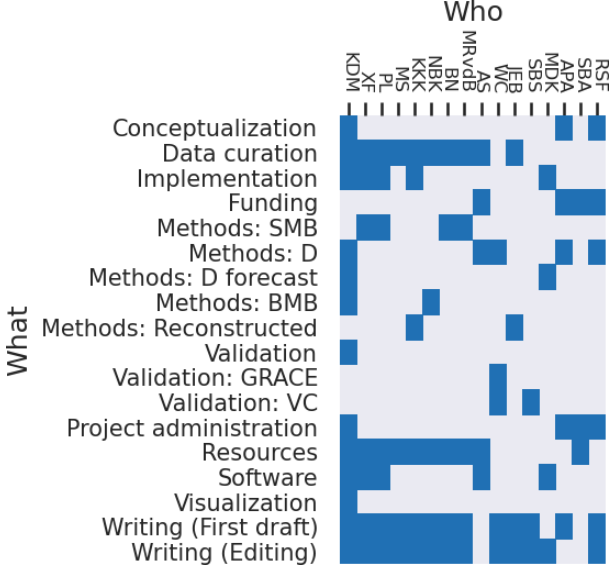
Figure G1. Author contributions following the CRediT